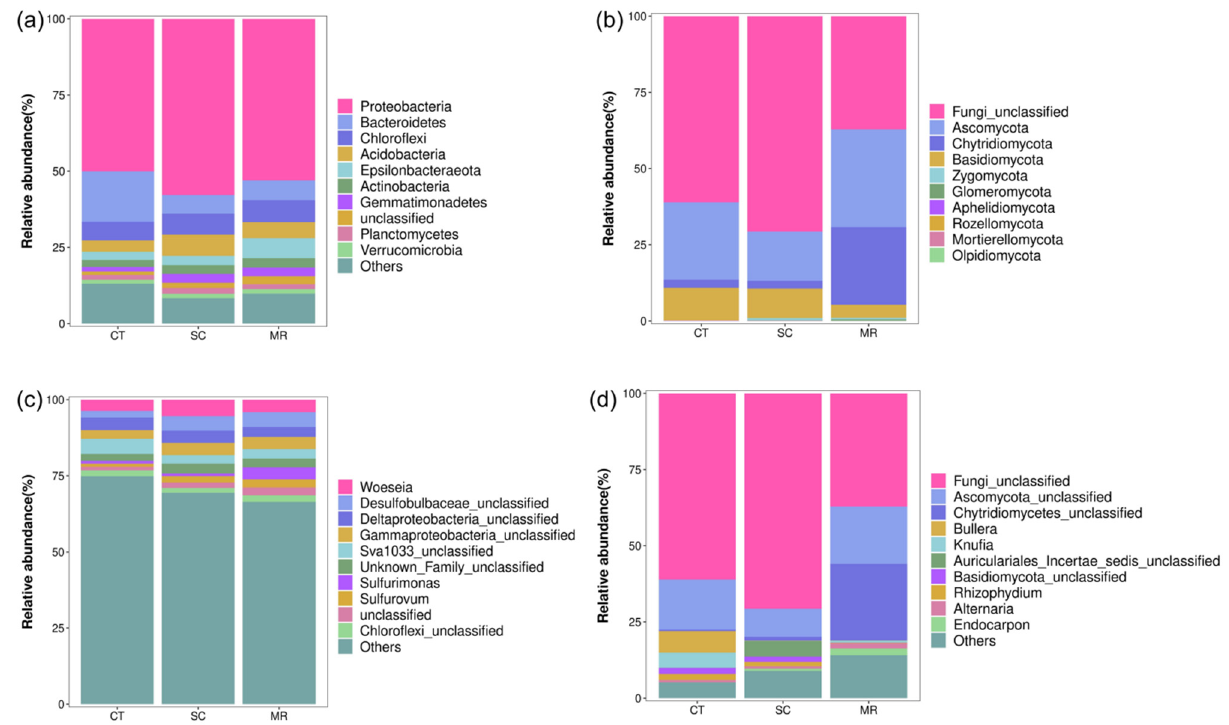
Figure 4. Bacterial ( a , c ) and fungal ( b , d ) community composition at the phylum ( a , b ) and genus ( c , d ) level.